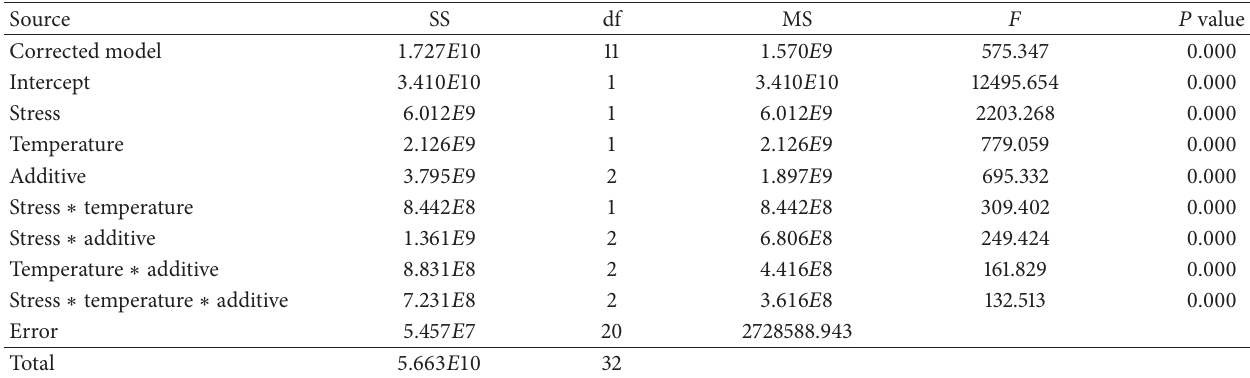
Table 9: Two-way ANOVA on ultimate